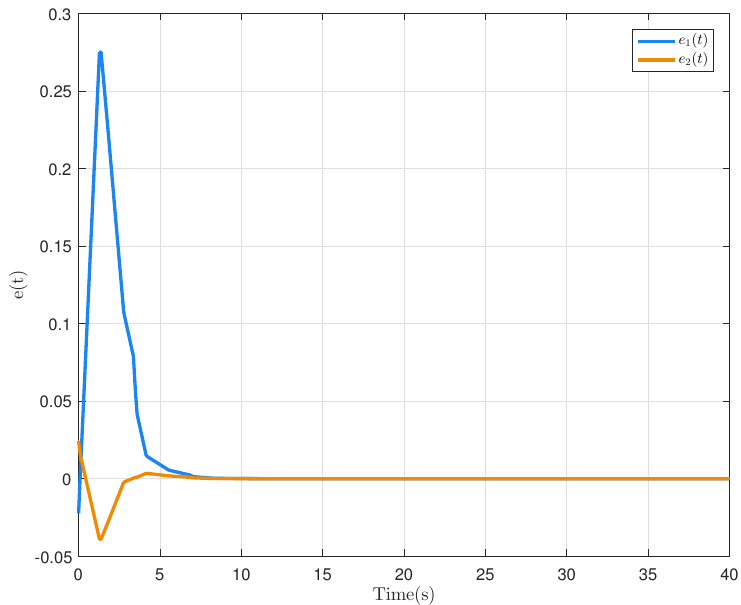
Figure 3. State responses of the error system.